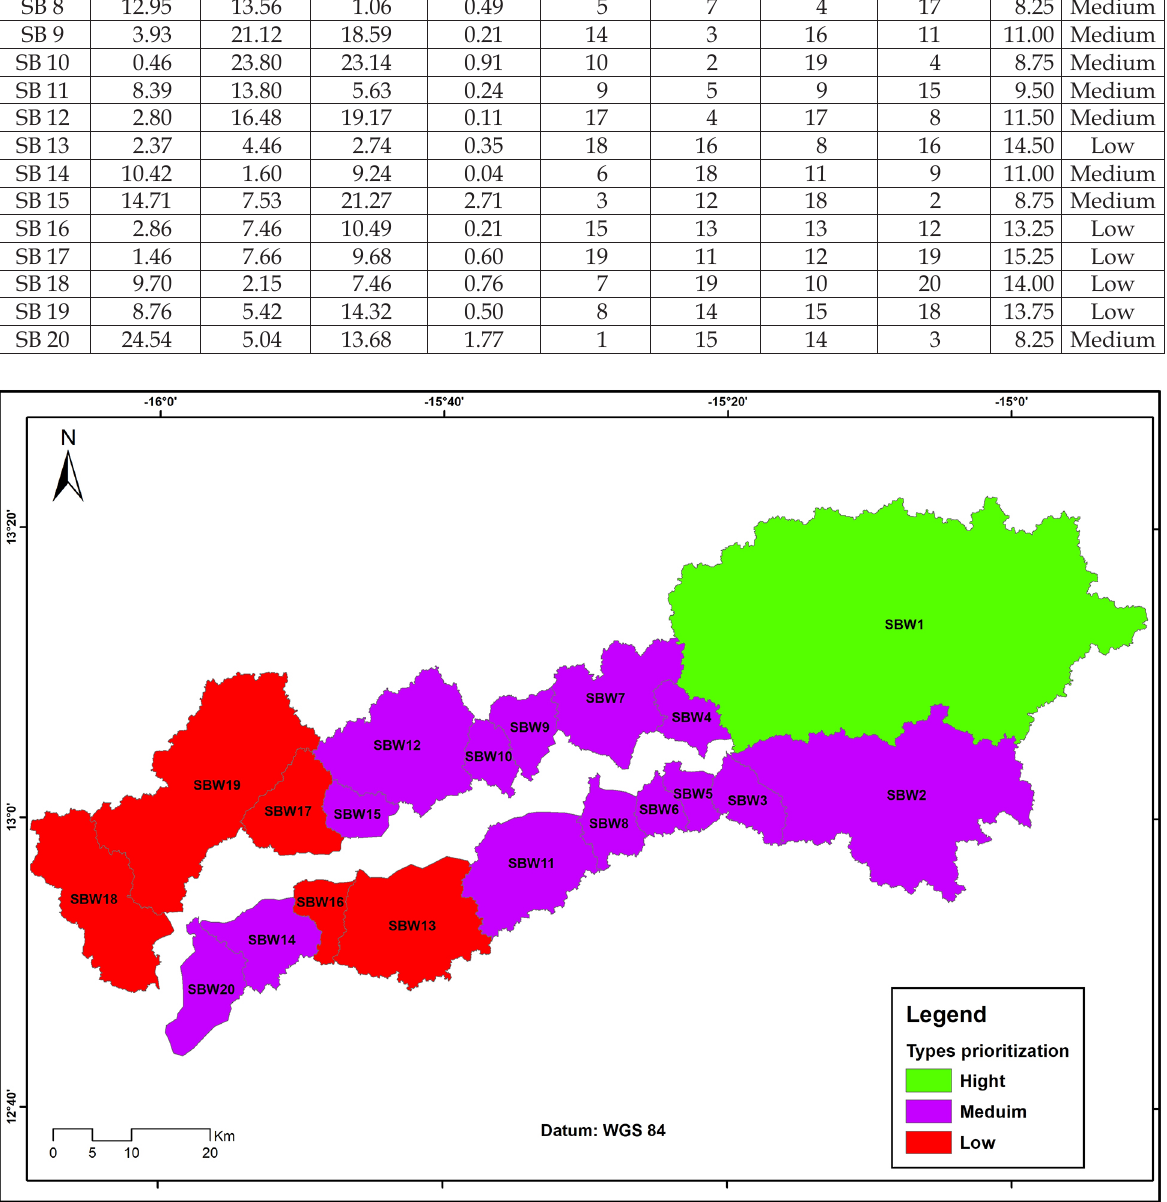
Fig. 7. Prioritisation based on percentage change in land use categories between 2000 and 2019 for the